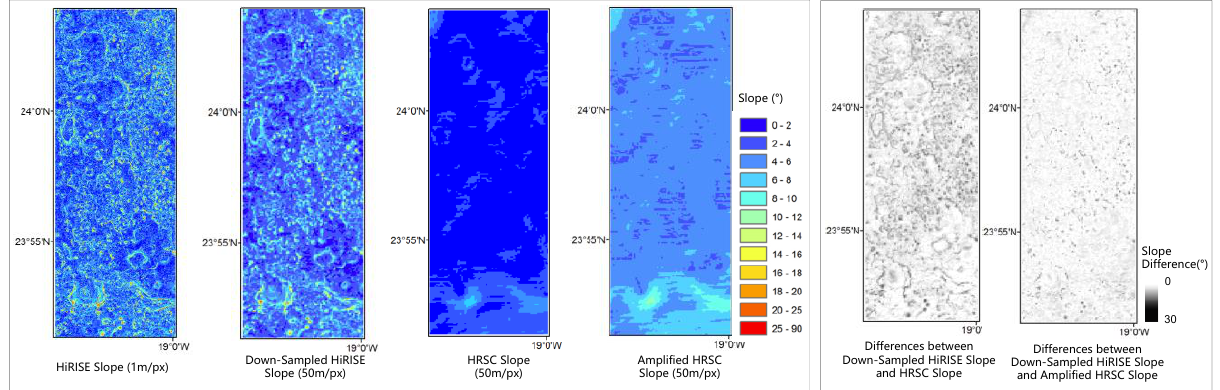
Figure 8. Verifications between HiRISE data and HRSC data.